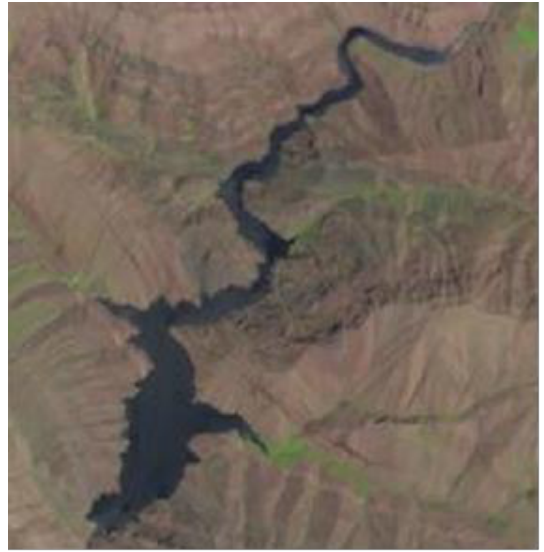
Figure 2 - Karaj Dam - satellite Landsat 8